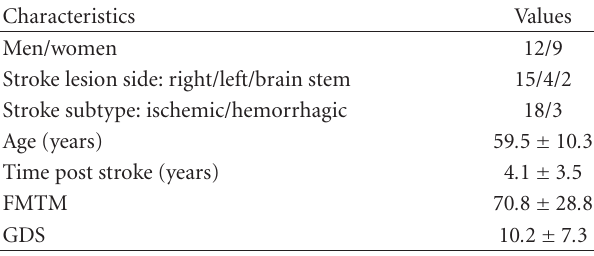
Table 1: Participant characteristics ( n = 21). Values are means ± SD.